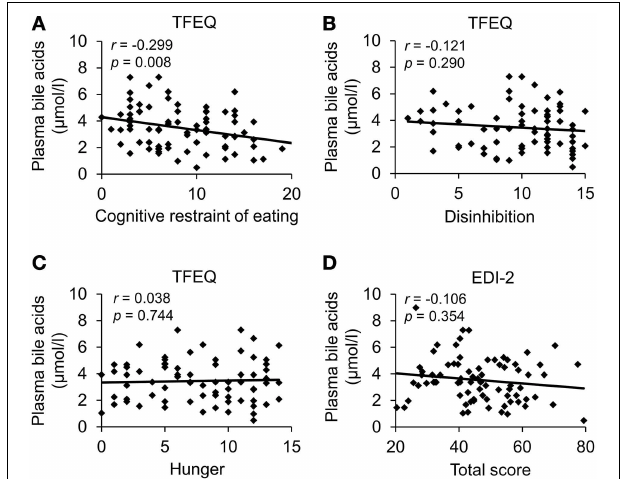
FIGURE 3 | Plasma bile acids show a negative association with cognitive restraint of eating in obese patients. A population of obese patients ( n = 85 ) with broad spectrum of disordered eating was investigated. Eating behavior was assessed using the Three-Factor Eating Questionnaire and the Eating Disorder Inventory. Plasma bile acids were negatively correlated with cognitive restraint of eating (A) , while no association was observed with disinhibition (B) , hunger (C) and the EDI-2 total score (D) . Values for r and p are indicated in the correlation graphs. Abbreviations: EDI-2, eating disorder inventory; TFEQ, Three-Factor Eating